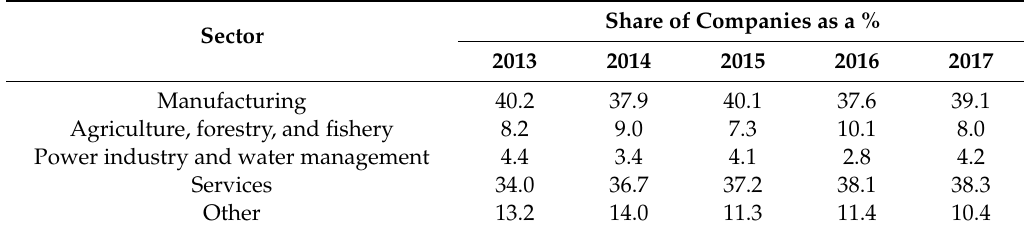
Table 3. Percentage share of companies operating in individual